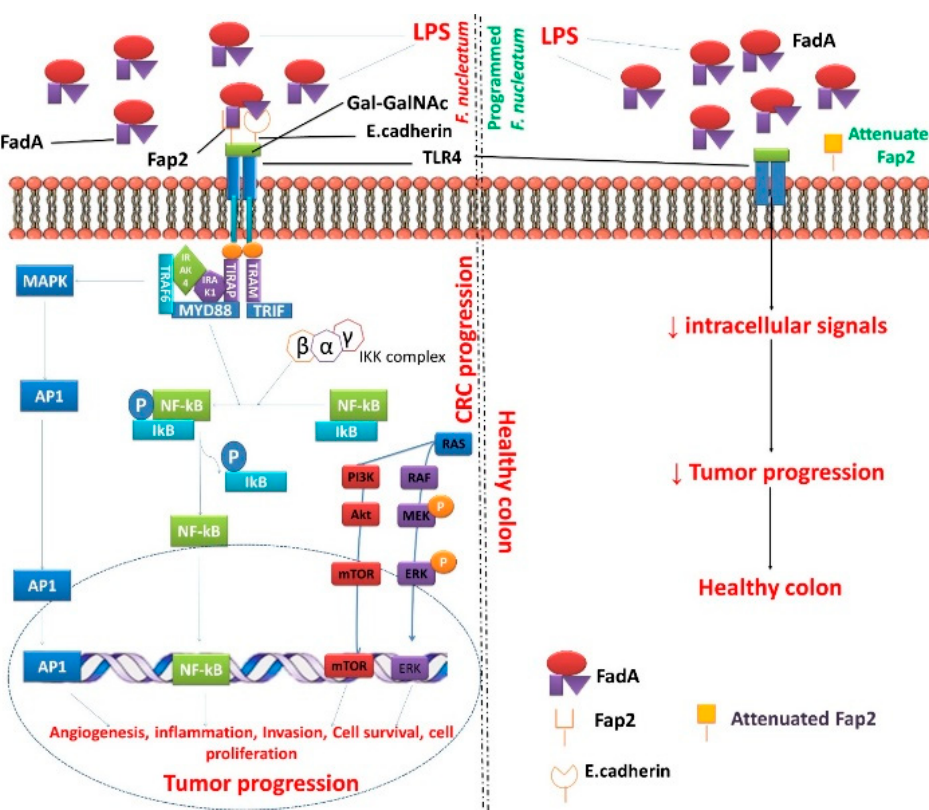
Figure 2. Programmed/attenuated F. nucleatum Fap2 as a potent factor for the treatment of CRC. Abbreviation: Akt-protein kinase B; Ap1-activating protein-1; ERK-extracellular signal-regulated